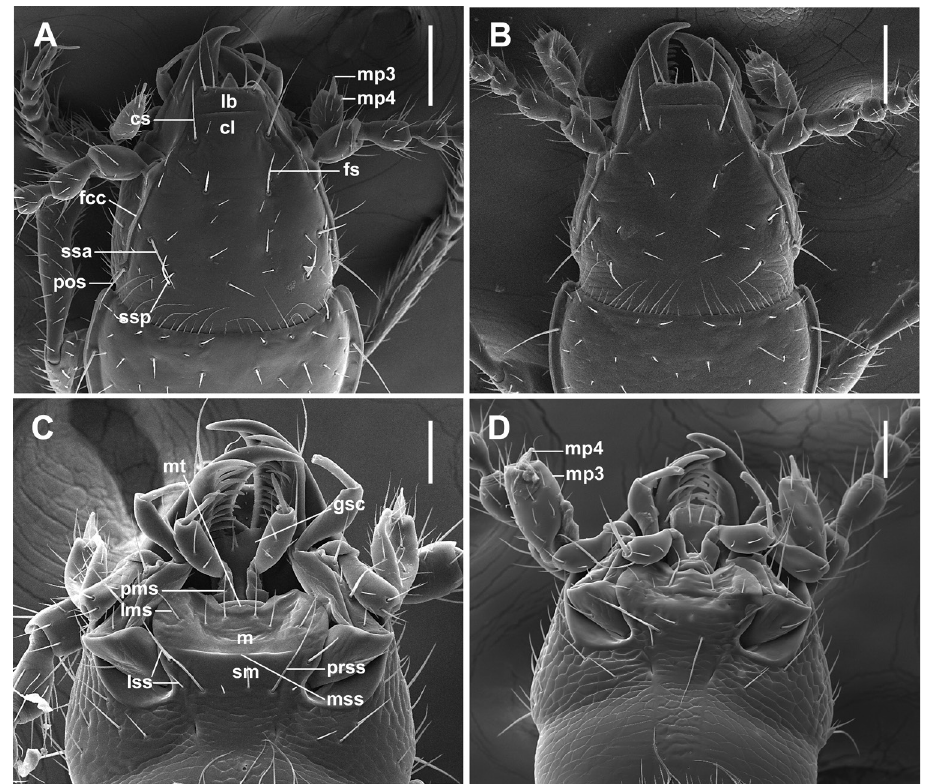
Figure 1. SEM illustrations of head, dorsal aspect, and labial complex, ventral aspect, of Pelodiaetus spe- cies. A, C P. sulcatipennis B, D P. nunni . Abbreviations: cl – clypeus; cs – clypeal seta; fcc –